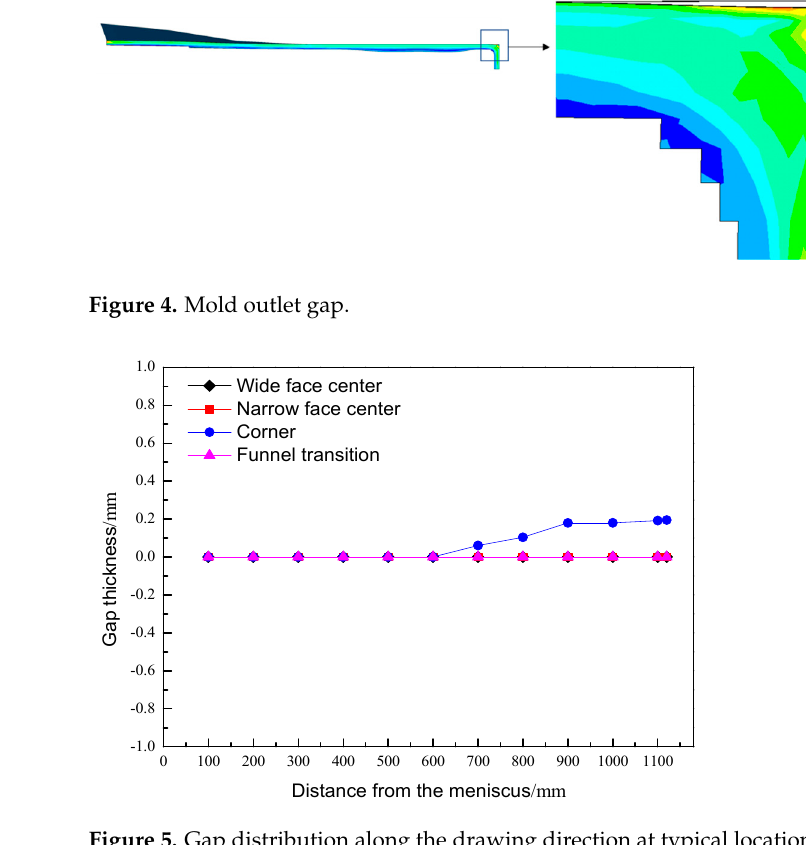
Figure 5. Gap distribution along the drawing direction at typical locations.